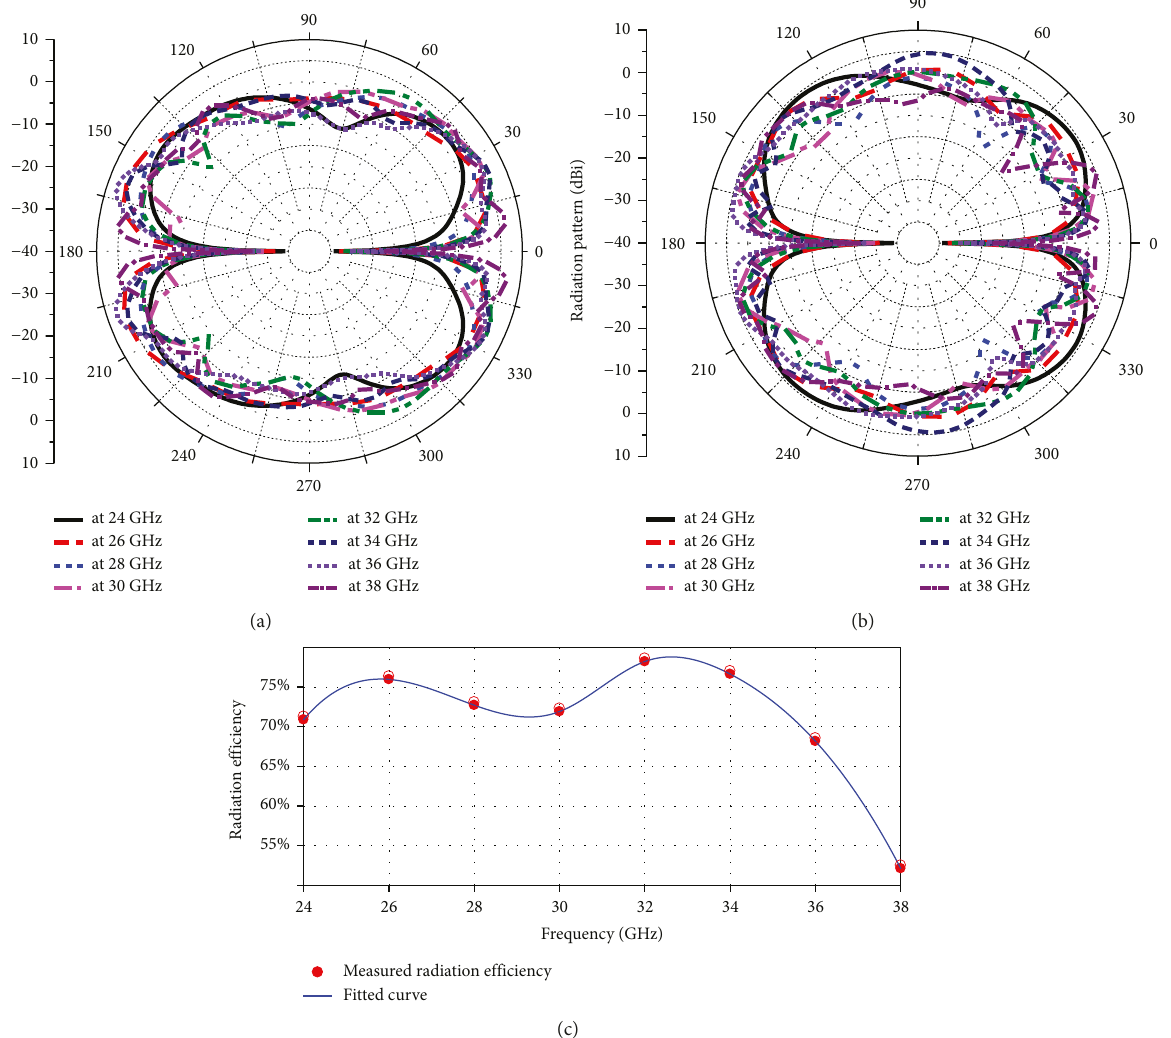
Figure 10: Measured radiation patterns of the proposed antenna on the (a) xoz-plane and (b) yoz-plane; (c) measured radiation e ffi ciency and fi tted curve of the antenna.